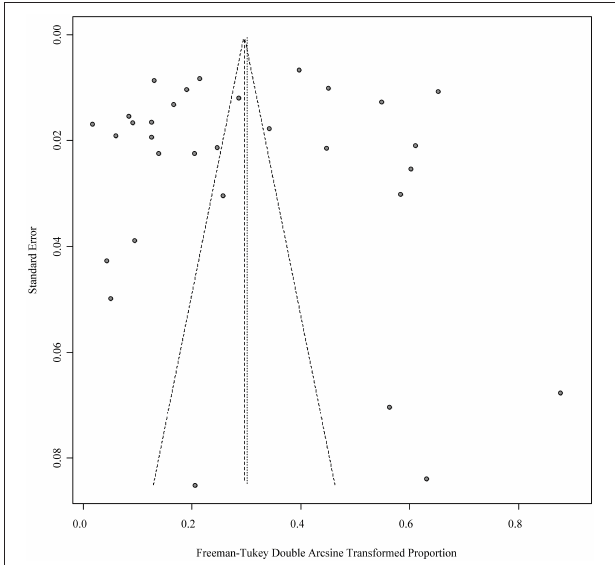
FIGURE 2 | Publication bias of studies by funnel plot (Immunological methods).